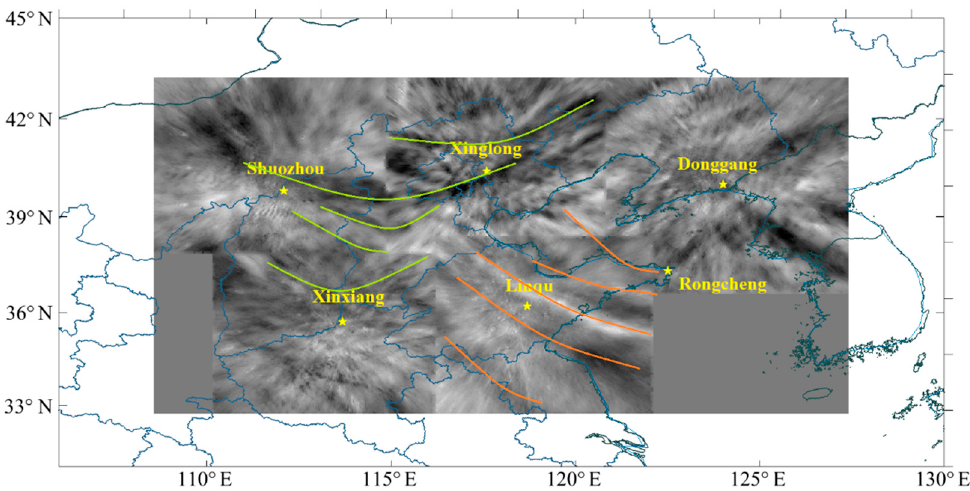
Figure 1. Airglow gravity waves captured at 18:00:07 p.m. (UTC) on 21 December 2014. The airglow image matrix is 2100 km × 1200 km. The all-sky airglow imager (ASAI) stations are marked with yellow stars. The two GW events are marked by orange and green, respectively. The blank area at the right lower corner is due to the breakdown of the ASAI at Rongcheng Station. The left lower corner is out of the effective radius of Xinxiang and Shuozhou station, so that the area is blank.